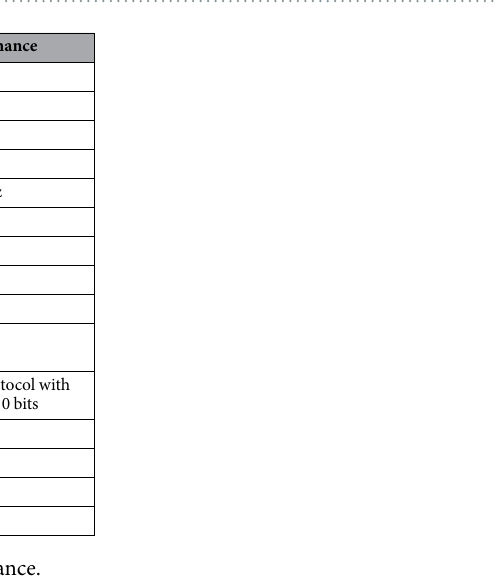
Figure 2. The TaiNi transmitter. ( a ) The device with battery and antenna-housing in place. ( b ) In use with a mouse. Orientation of the device depends on the orientation of the implant on the mouse’s head. ( c ) Packet loss using a single antenna elevated 25 cm above the bench on which the transmitter was positioned. ( d ) Time- domain output from the system, given a constant amplitude + / − 2 mV input with frequency sweep from 0.1 Hz to 100 kHz. ( e ) Log-scale frequency response. ( f ) Enlarged view of the lower end of the frequency response, showing slight signal attenuation in the slow-wave/lower-delta frequency range.